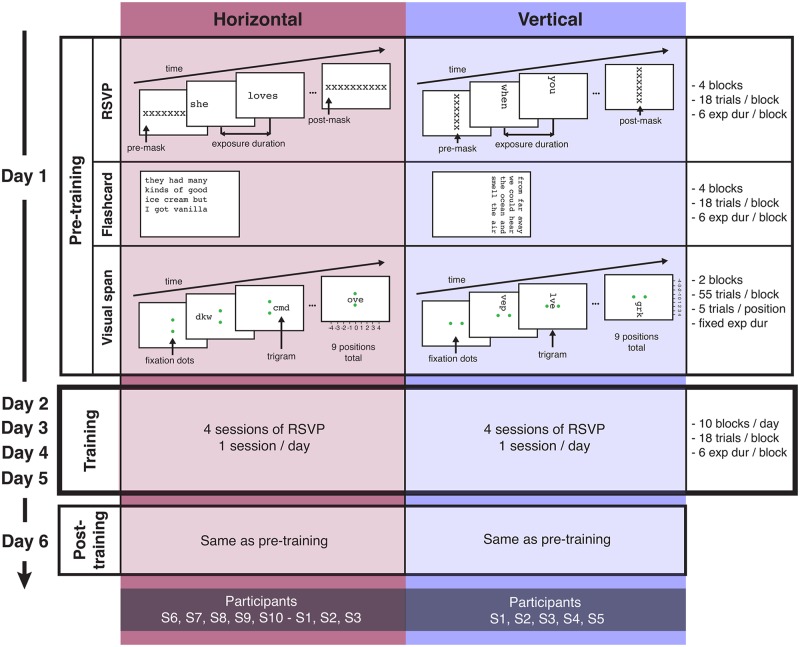
Testing procedure.